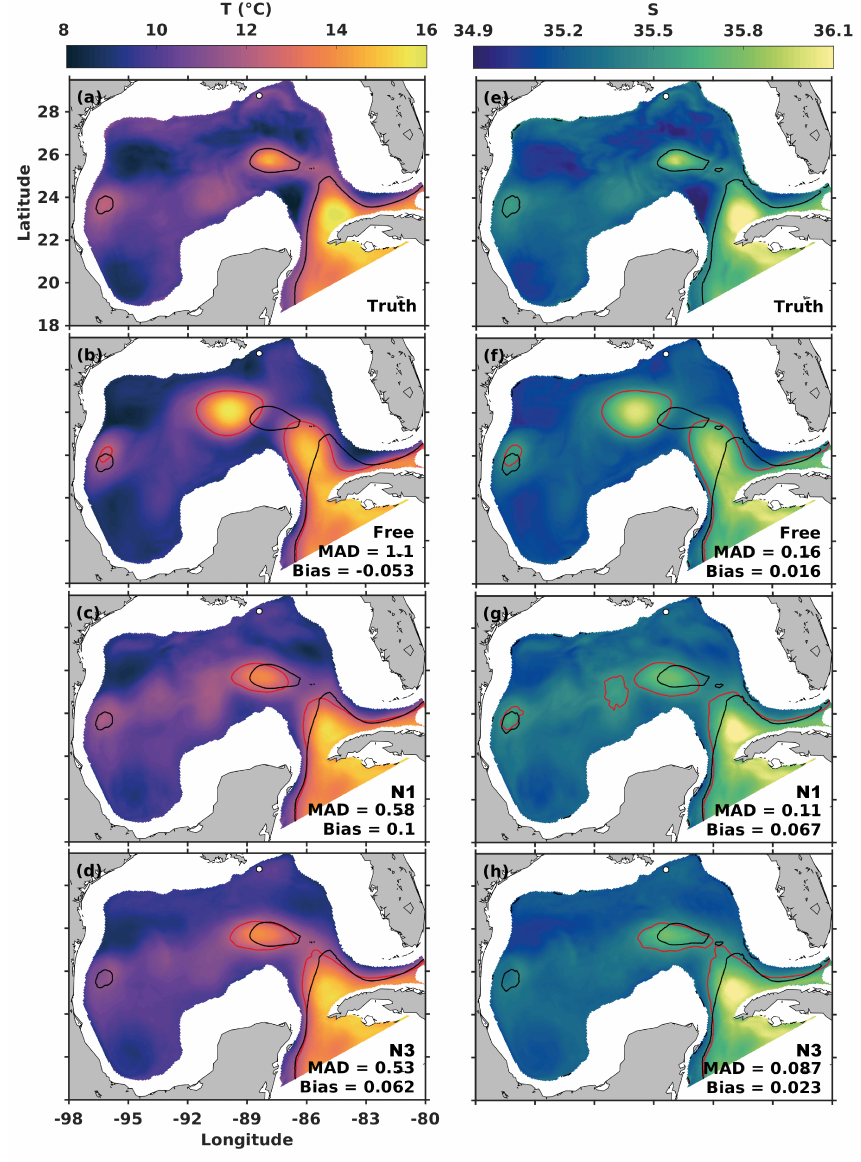
Figure 8. August mean (a, b, c, d) temperature ( T , ◦ ) and (e, f, g, h) salinity ( S ) at 400m from the “truth”, free, N1, and N3 run in nonidentical twin experiments. The white dot denotes the location of the Deepwater Horizon oil rig. The contours mark the 12 ◦ isotherm and 35.5 isohaline, respectively; the black contours denote the isotherm or isohaline for the truth, while red contours denote those for the actual simulation in each panel. The horizontal domain-averaged MAD and bias values at 400m for each experiment relative to the truth are also presented in the respective